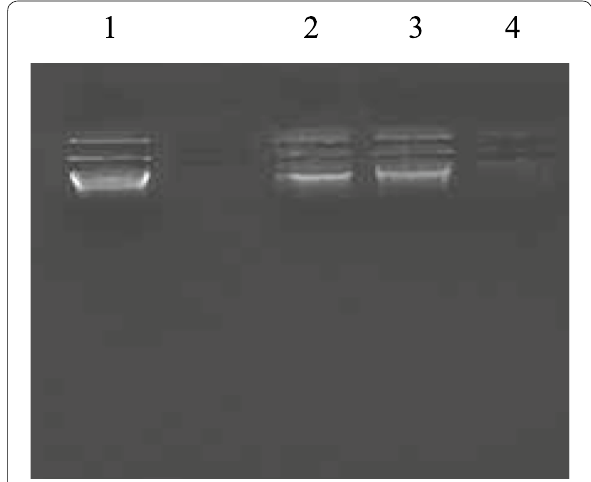
Fig. 4 Photograph showing the effects of synthetic molecules on calf thymus DNA. Lane 1: Untreated DNA, lane 2: 12c , lane 3: 10e , lane 4: